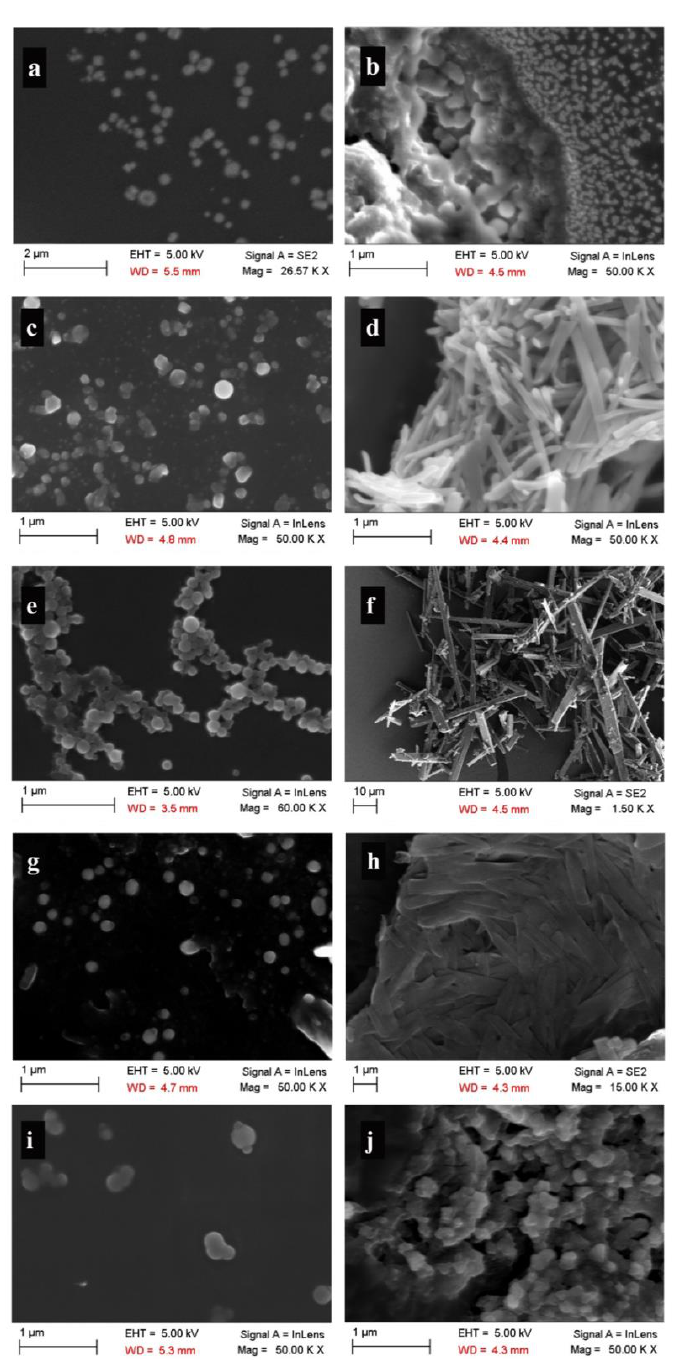
Figure 3. SEM images of particles of ( a ) AMIa, ( b ) AMIb, ( c , d ) COU, ( e , f ) CUR, ( g , h ) NOR, and ( i , j ) PRO generated by antisolvent precipitation method. ( a , c , e , g , i ) Solvent-evaporated particles. ( b , d , f , h , j ) Freeze-dried particles.